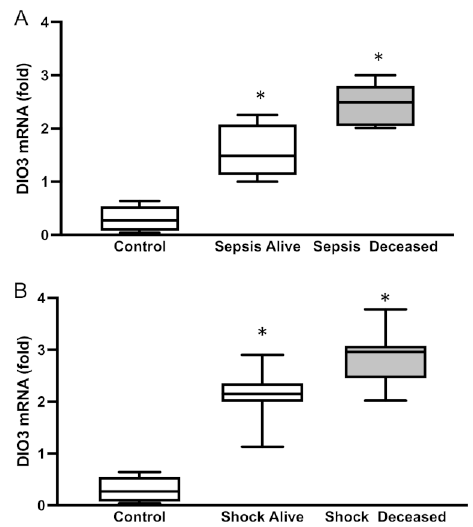
Figure 2. DIO3 mRNA levels in patients with ( A ) sepsis or ( B ) septic shock. Mean ± SEM, * p < 0.0001 by ANOVA. D3: type 3